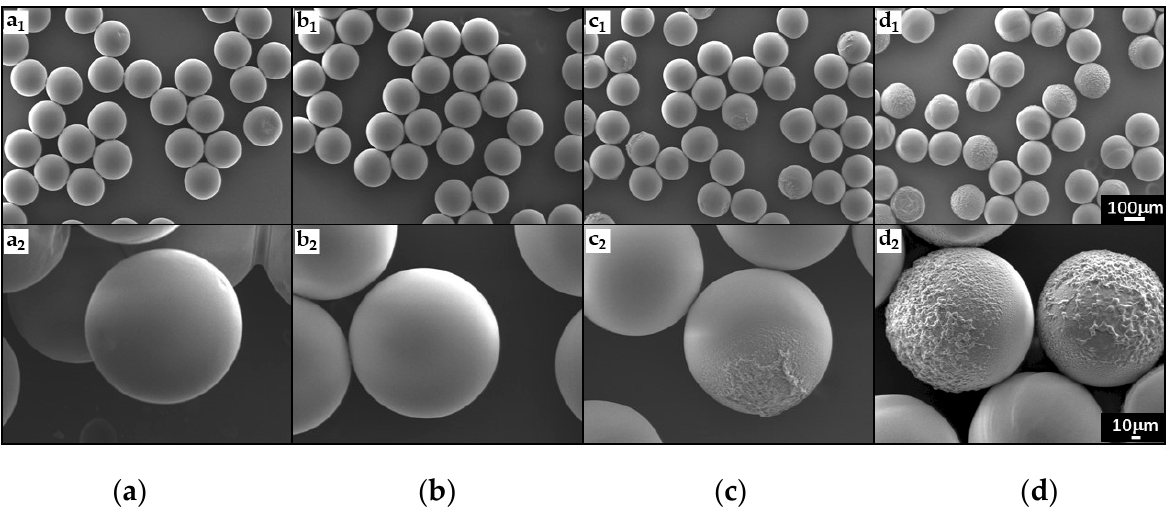
Figure 11. SEM images of PEGDA particles prepared with different amounts of water in the dispersed phase: ( a ) 0 wt%; ( b ) 30 wt%; ( c ) 40 wt%; ( d ) 50 wt%. 100 μ m scale bar applies to figures ( a 1 – d 1 ), and 10 μ m scale bar applies to figures ( a 2 – d 2 ).